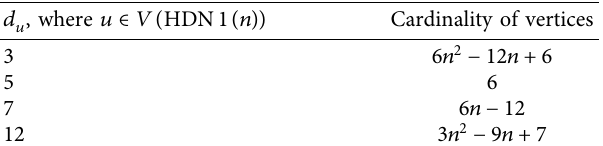
Figure 2: Hex-derived network HDN1 ( 4 ) . Table 1: Vertex partition of HDN1 ( n )